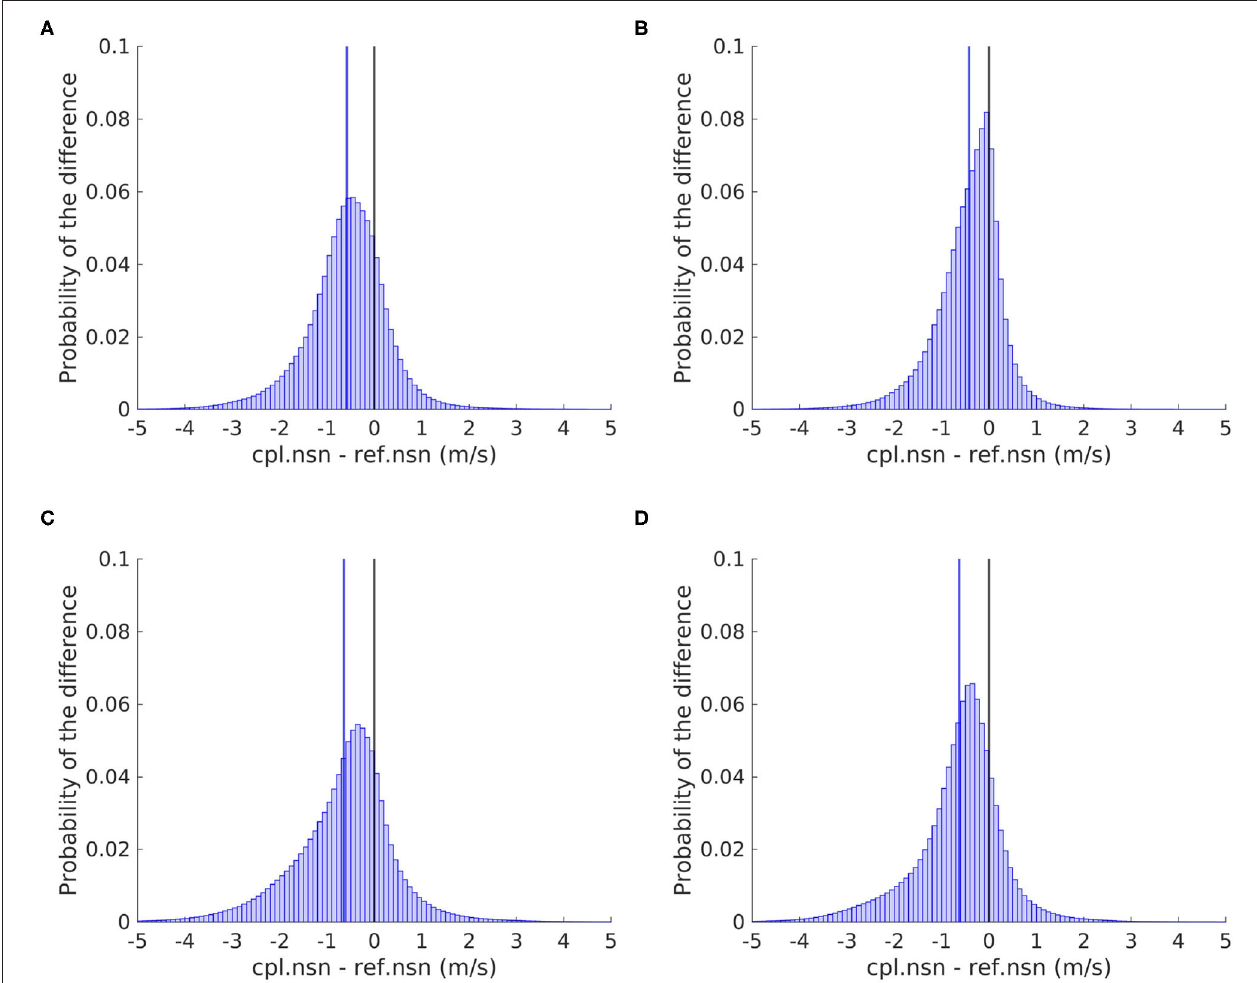
FIGURE 3 | Histogram of the difference in the wind speed between the coupled (cpl.nsn) and reference (ref.nsn) ensembles within the North Sea (A) , the Baltic Sea (B) , the southern Norwegian Sea (C) , and the North Atlantic Ocean west of the British Isles (D) . The blue line indicates the mean of the distribution, and the black indicates the zero